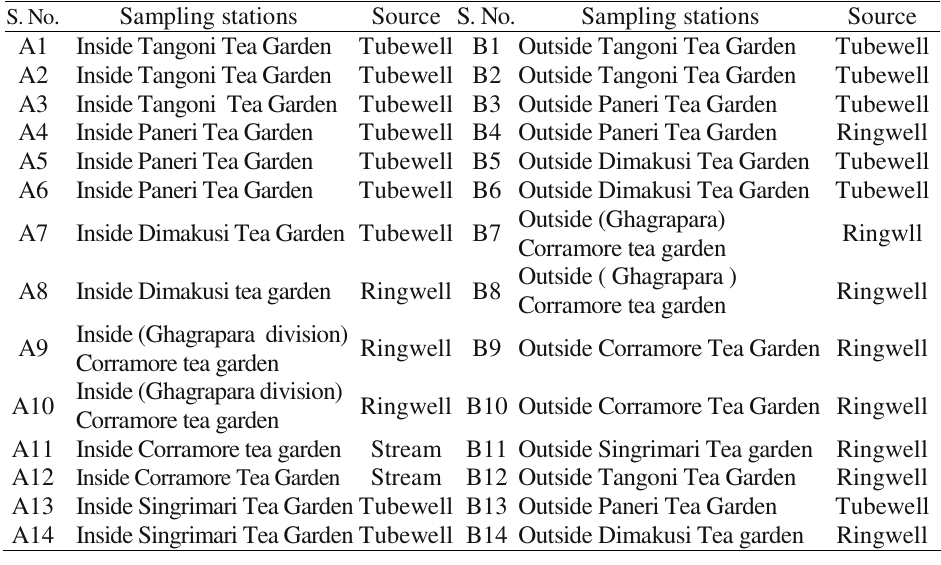
Table 1. Water sampling locations and